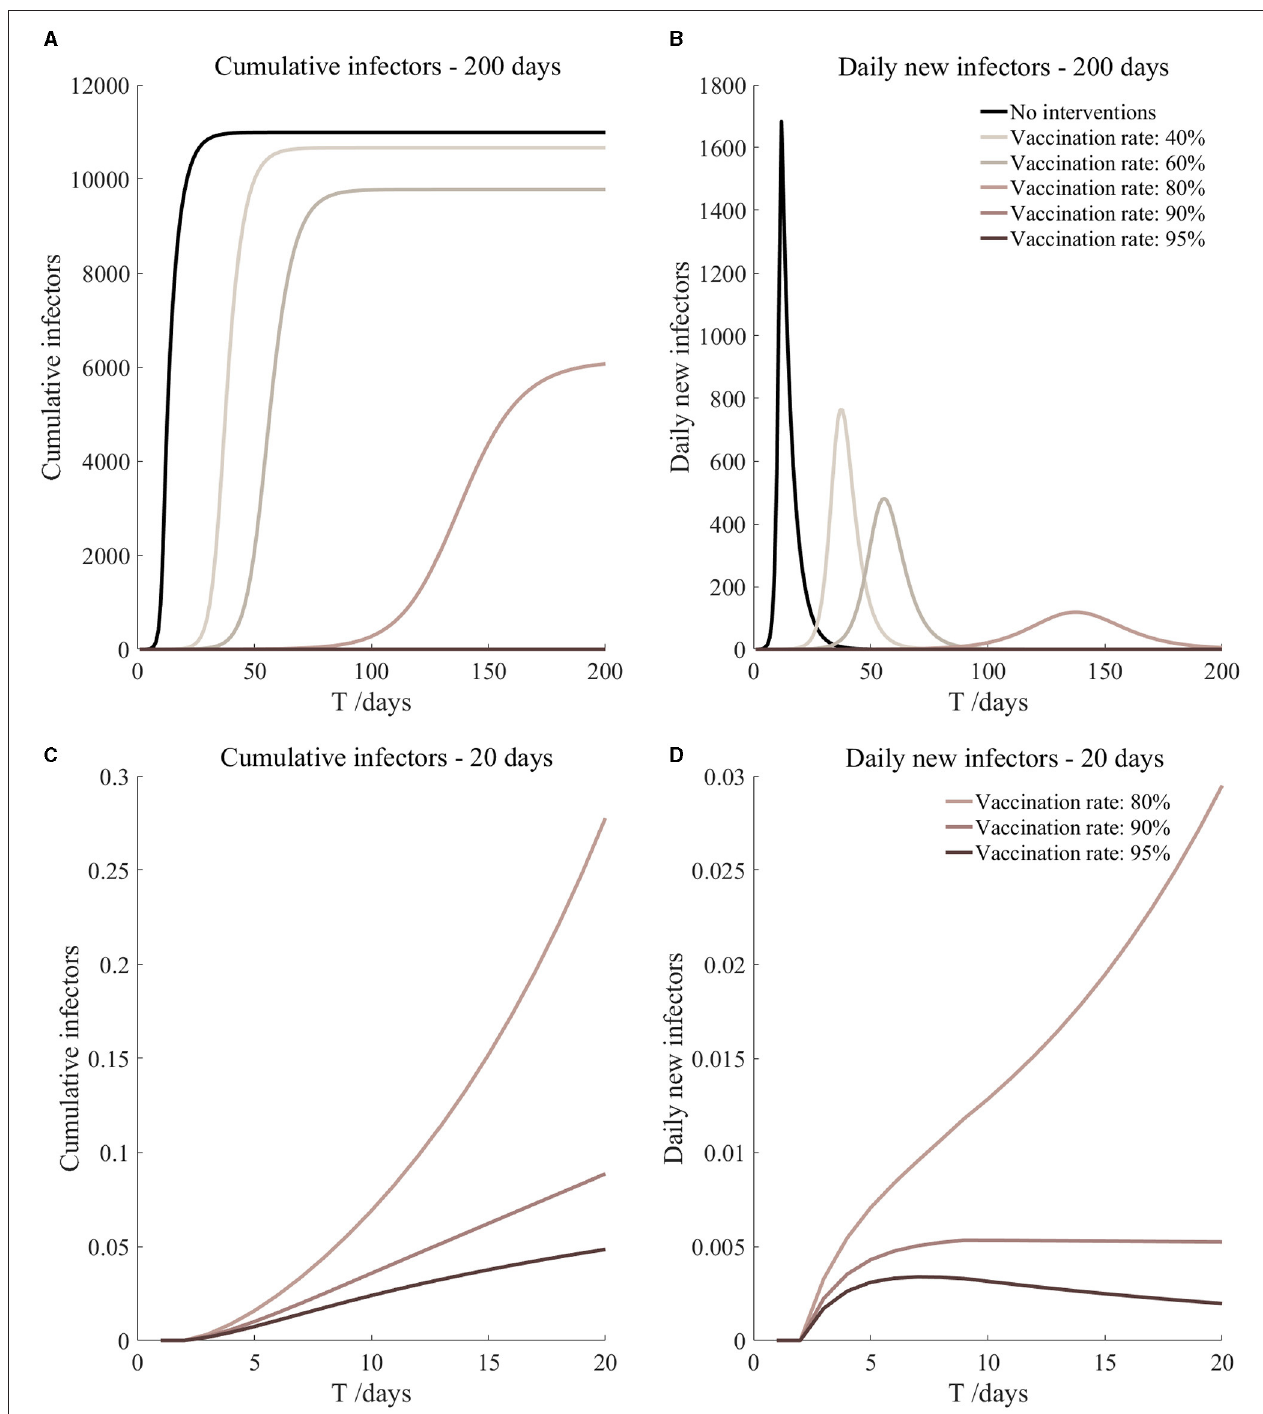
FIGURE 15 | Vaccination and 14-day compulsory quarantine. Assume pre-flight screening can identify 20% of asymptomatic infectors, 14-day compulsory quarantine has about a 4% risk of missed detection.